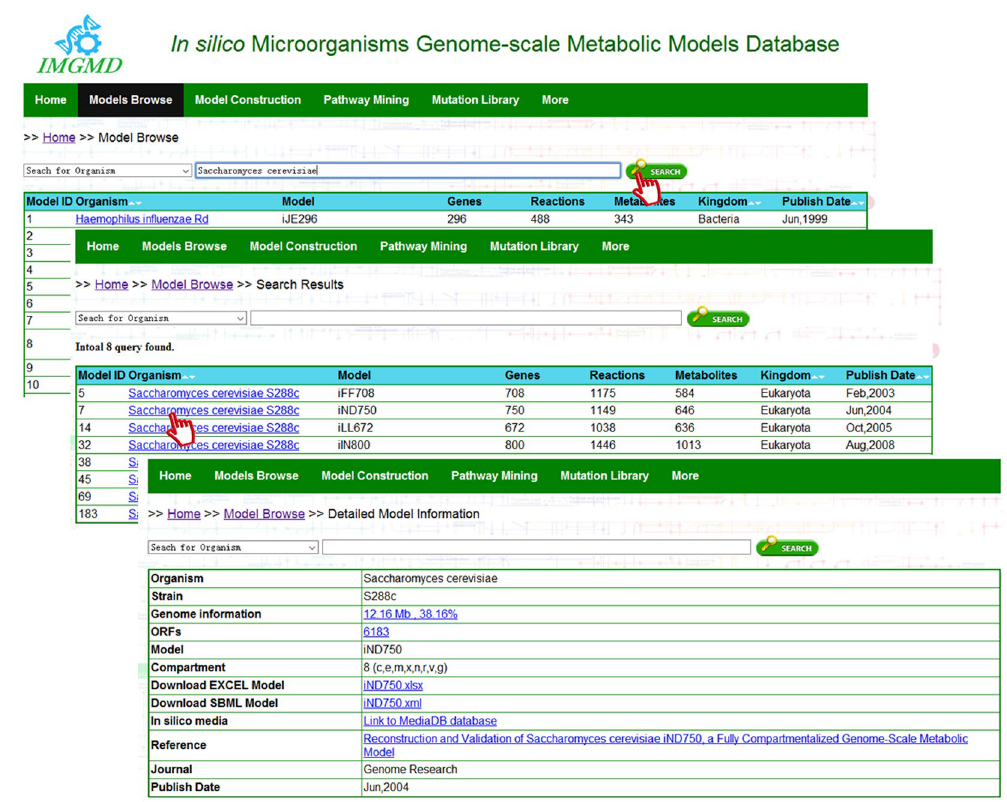
Figure 2. The ‘models browse’ module in IMGMD. Search results for Saccharomyces cerevisiae in model browse, and the detailed information on model i